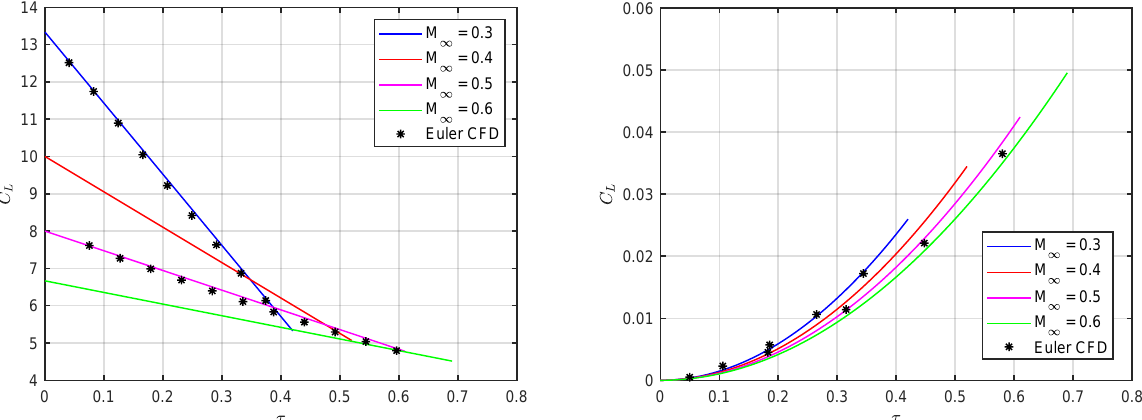
Figure 15. The incipient indicial lift for rectangular swept wing in compressible flow: AOA ( left ) and SEG ( right ), with η = 20 and Λ = 30 ◦